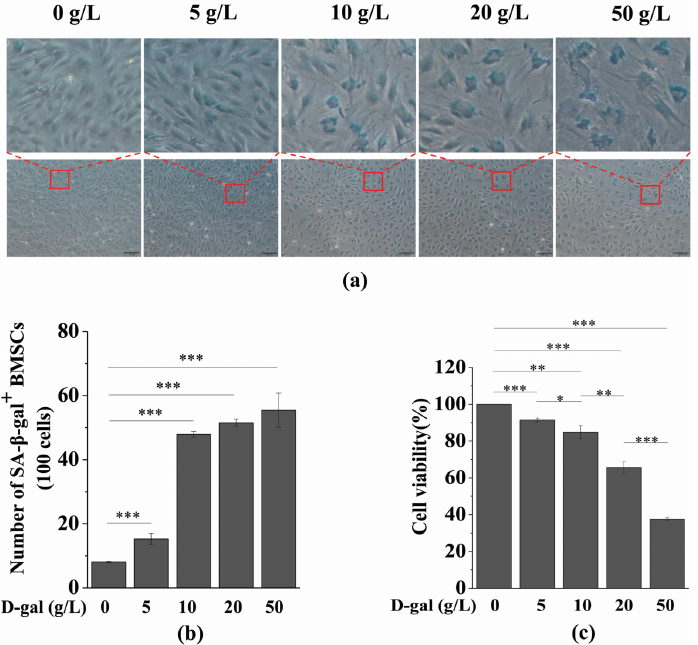
Figure 1. Effects of different concentrations of D ‐ gal on BMSC senescence. BMSCs were induced by different concentrations of D ‐ gal for 48 h. ( a ) Senescence ‐ associated galactosidase staining was used to detect SA ‐β‐ gal activity (scale bar = 100 μ m). The upper column is a partial enlarged view of the original image below. ( b ) Quantitative analysis of SA ‐β‐ gal ‐ positive cells. The intensity of SA ‐β‐ gal staining was determined by means of the percentage of SA ‐β‐ gal + cells (100 cells). ( c ) A CCK ‐ 8 assay was used to detect cell viability. The data are expressed as means ± standard devia ‐ tion. n = 3, * p < 0.05; ** p < 0.01; *** p < 0.001. BMSCs: Bone marrow ‐ derived mesenchymal stem cells; D ‐ gal: D ‐ galactose; SA ‐β‐ gal: Senescence ‐ associated galactosidase staining; CCK ‐ 8: Cell Counting Kit ‐ 8.